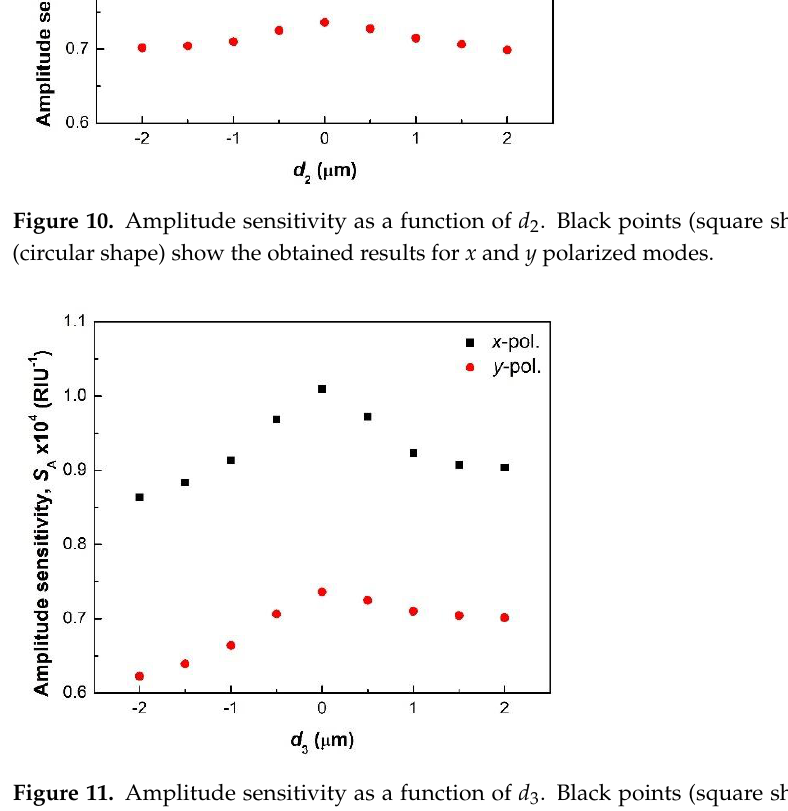
(circular shape) show the obtained results for x and y polarized modes.